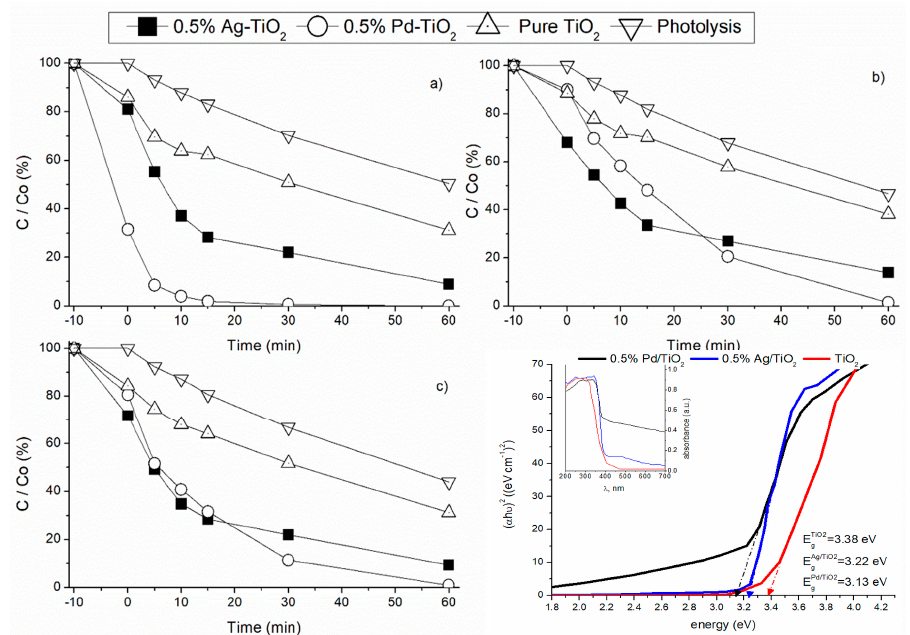
Figure 4. Contaminant (( a ) SMX, ( b ) CBZ and ( c ) LRZ) degradation over time during photolysis and photocatalytic oxidation using titanium dioxide-based photocatalysts under sunlight radiation. ( d ) Determination of the catalysts’ band gap through the Tauc plot method (inset: catalysts